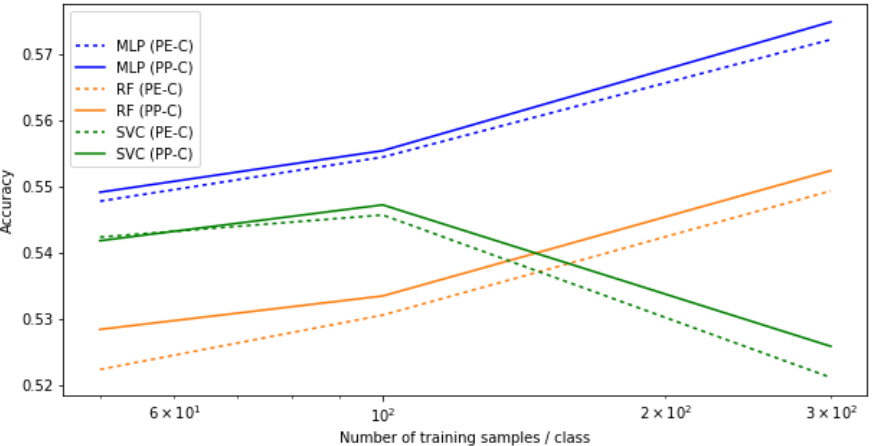
Figure 8. Accuracy for smaller parcels increases using posterior predictive LGPDE classification.